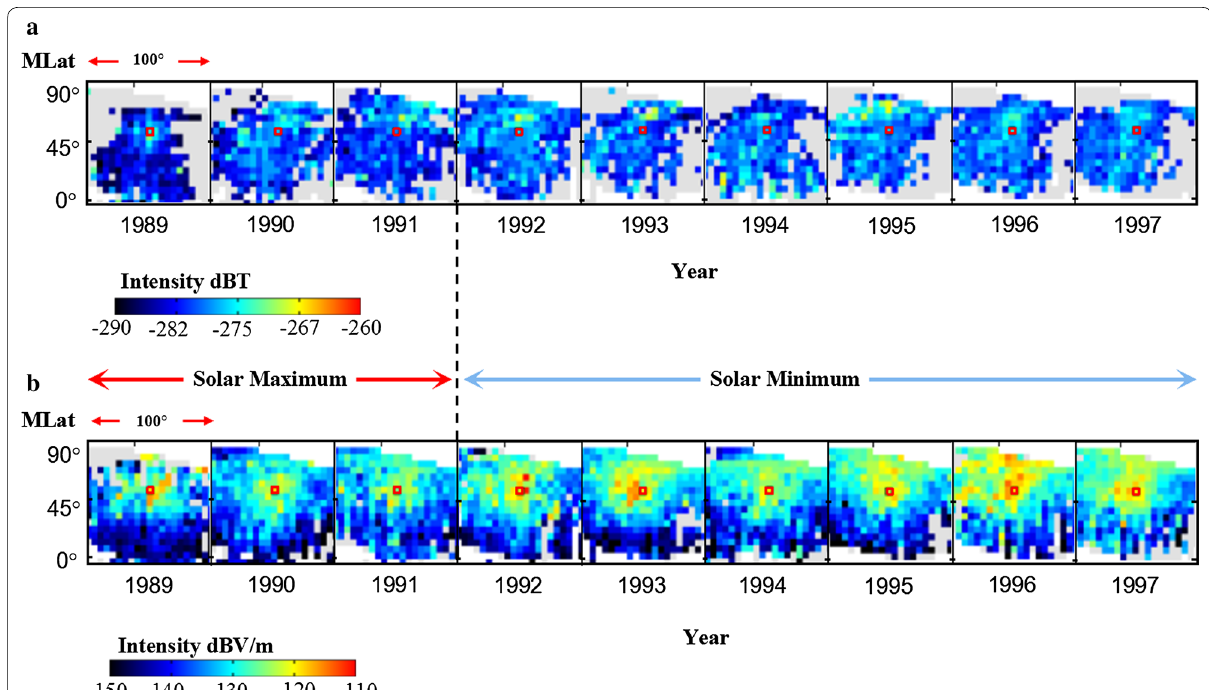
Fig. 12 Annual propagation of the Omega signal from the Norway station in the magnetic field and b in the electric field. The red arrow indicates the width of the map (~100°) with location of the station in the center (indicated by the rectangle